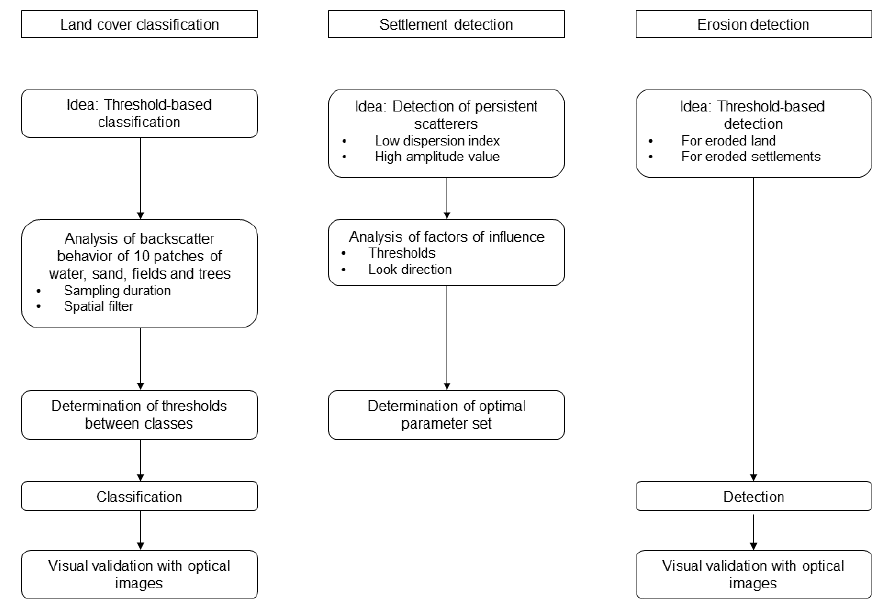
Figure 1. Overview of the analytical strategy to develop an algorithm detecting eroded farmland and